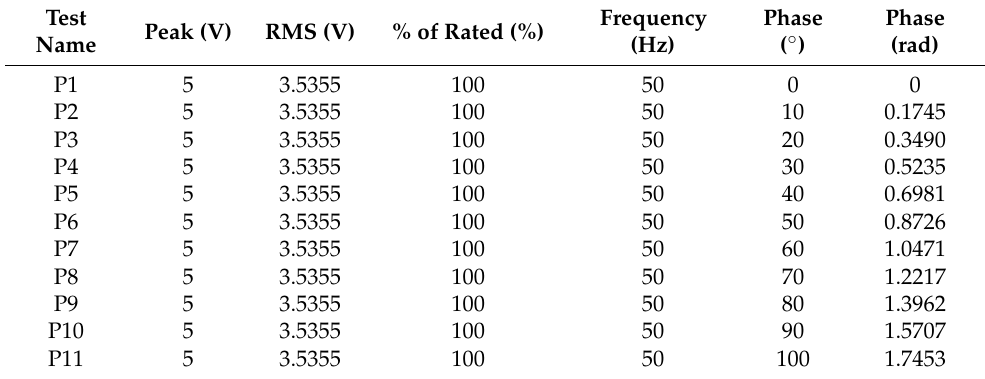
Table 14. Settings of the phase tests.